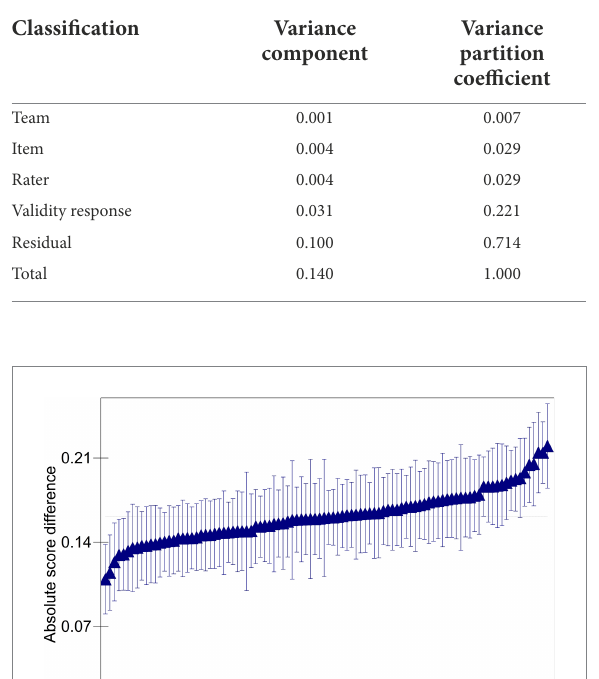
TABLE 3 Variance components and variance partition coefficients.